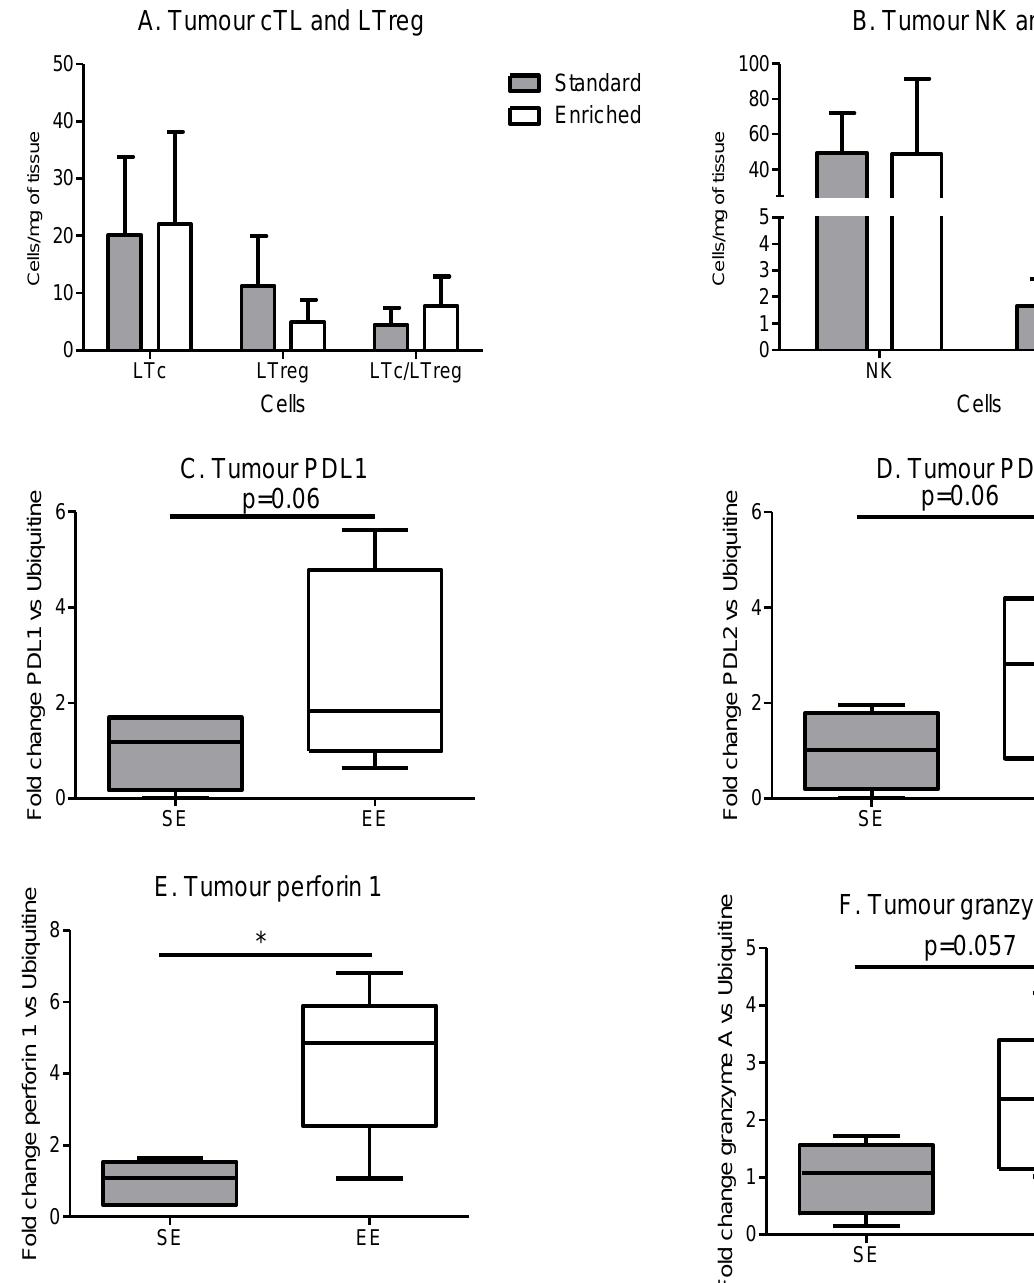
Figure 7. Spontaneous physical activity increases immune efficacy without changes in cTL and NKs. ( A ) Tumour lymphocytes T cytotoxic and regulator infiltrate, results are in cells per mg of tumour. ( B ) Tumour NK and NKt infiltrate, results are in cells per mg of tumour. ( C ) Expression of PDL1 in tumour microenvironment, results are in relative expression of mRNA by RT-qPCR, normalized with ubiquitin. ( D ) Expression of PDL2 in tumour microenvironment, results are in relative expression of mRNA by RT-qPCR, normalized with ubiquitin. ( E ) Expression of perforin 1 in tumour microenvironment, results are in relative expression of mRNA by RT-qPCR, normal- ized with ubiquitin. ( F ) Expression of granzyme A in tumour microenvironment, results are in relative expression of mRNA by RT-qPCR, normalized with ubiquitin. Phenotyping is performed on 5 mice tumour/group. mRNA expression is performed on 5 mice tumour samples/group. Data are expressed as mean ± SEM. Data were analysed by Mann–Whitney t -test. Representative data are shown: * p < 0.05, SE vs.